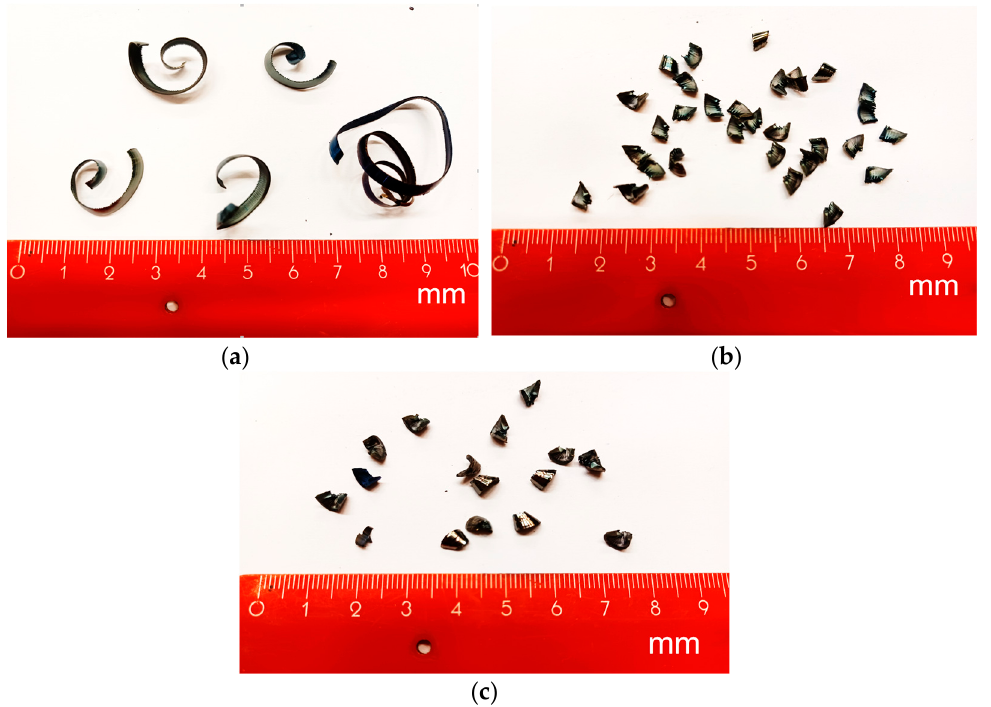
Figure 5. Chips after machining 62SiMnCr4 tool steel, v c = 145 m/min and feed: ( a ) f = 0.2 mm; ( b ) f = 0.4 mm; ( c ) f = 0.6 mm.